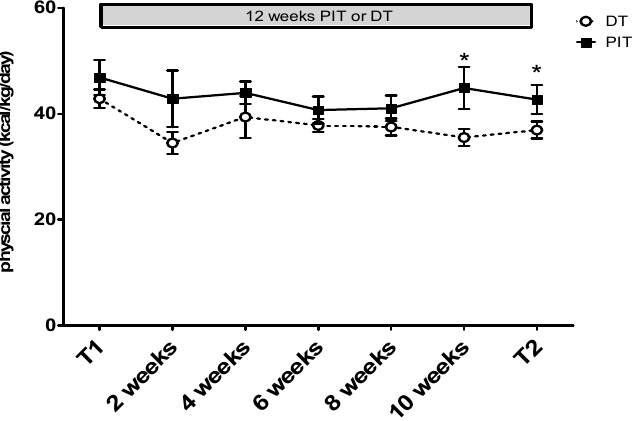
Table 2. The body composition of PIT and DT.